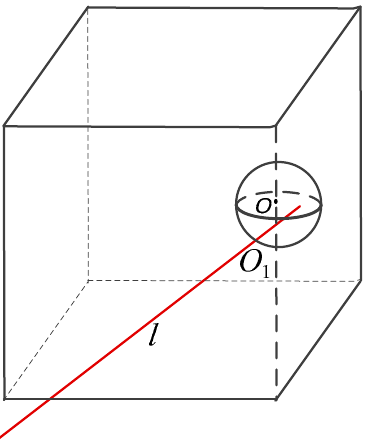
Figure 3. Schematic showing the method used to determine the diffraction point. The red line represents ray l , the cuboid denotes the barrier, the sphere represents a virtual receiving sphere, O is the center of the virtual receiving sphere, and O 1 is the point where the ray l intersects with the virtual receiver sphere.